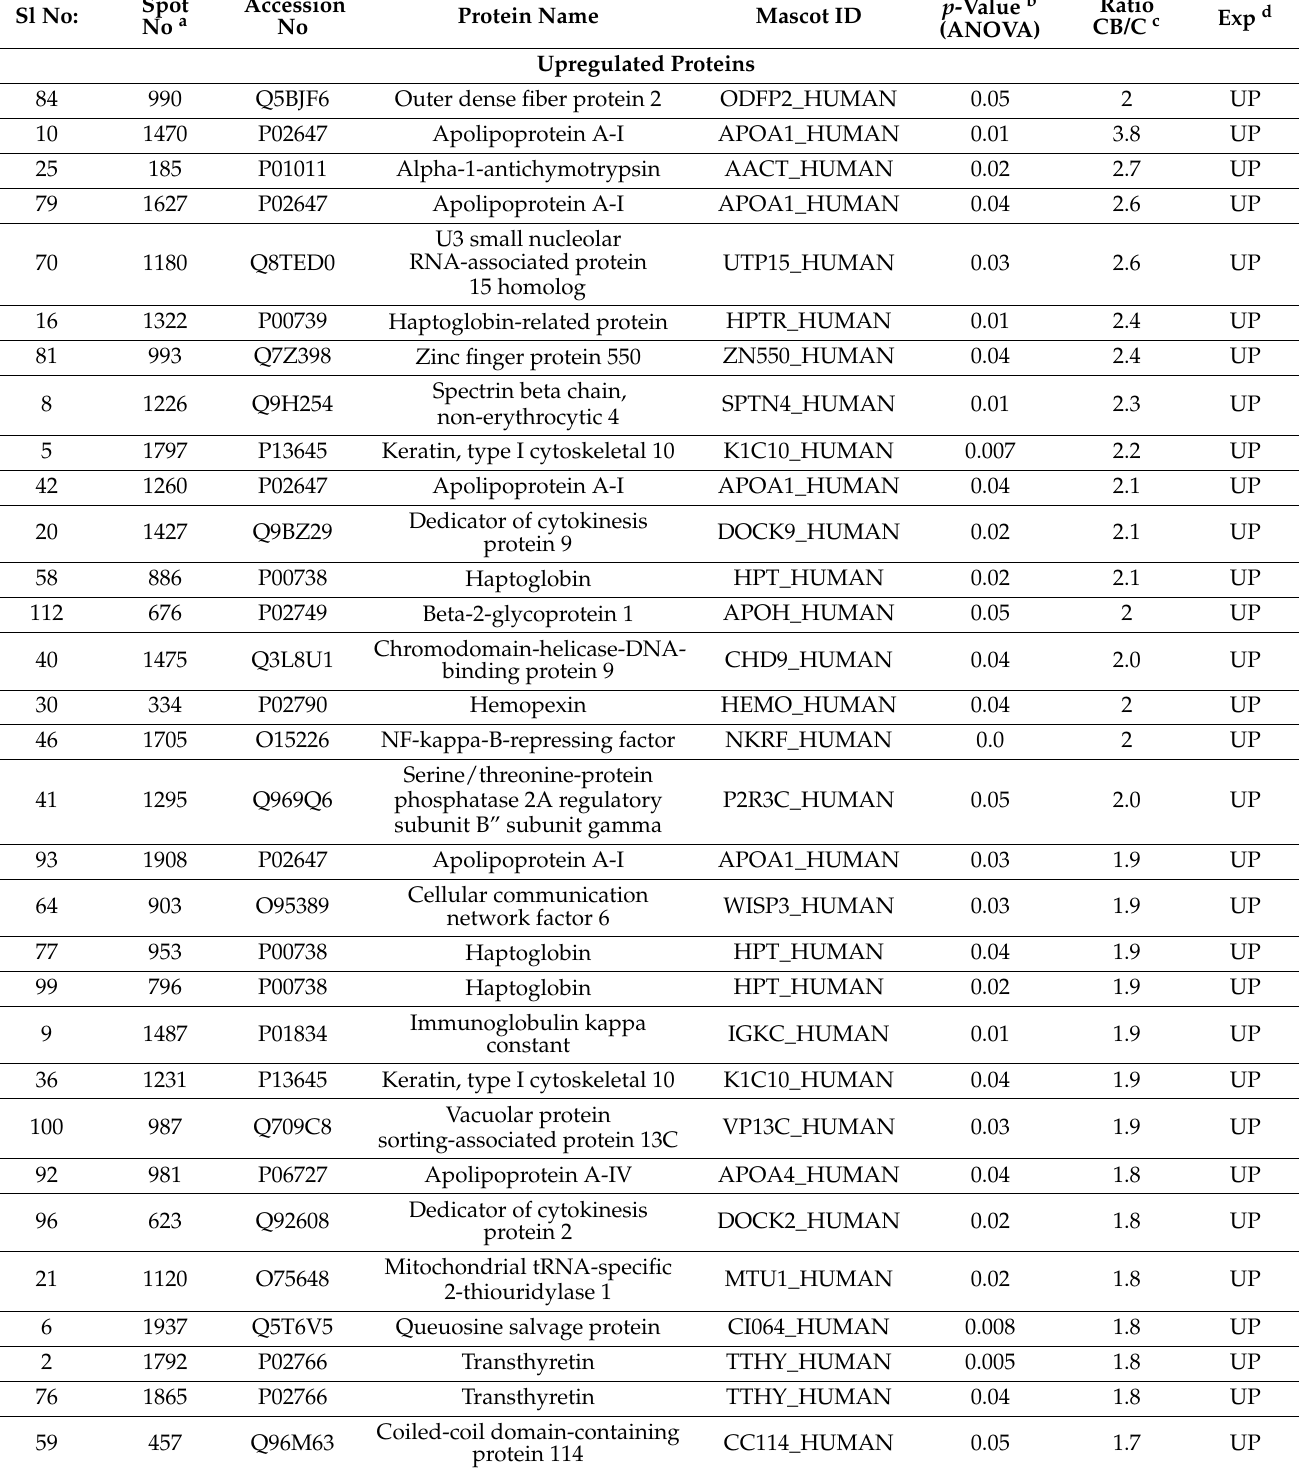
Table 2. Identified proteins with changes in abundance between CUD and control samples. The table displays average ratio values for control and treated samples with their corresponding levels of fold changes and p -values for one-way ANOVA ( p -value < 0.05) using 2D-DIGE. Analysis type: MALDI-TOF; database: SwissProt; taxonomy: Homo sapiens . a Protein accession number for SWISSPROT Database. b p -Value (ANOVA). c Ratio between the groups d Protein expression between the